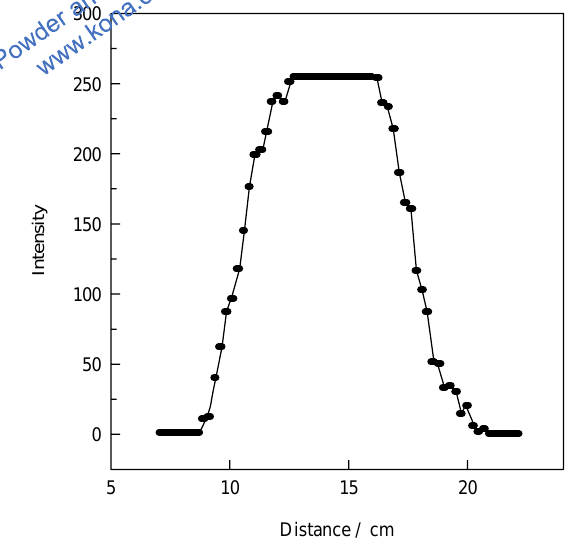
Fig. 8 Scan of X-ray intensity across a horizontal plane through the equator of a single bubble in a Group B powder